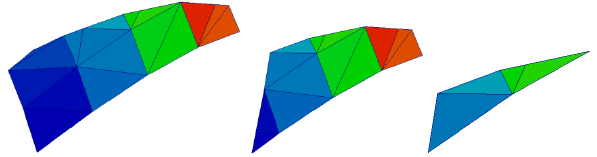
Figure 5. Exact clipping steps of narrPd with T i . The sequence from left to right illustrates the edge clipped results.